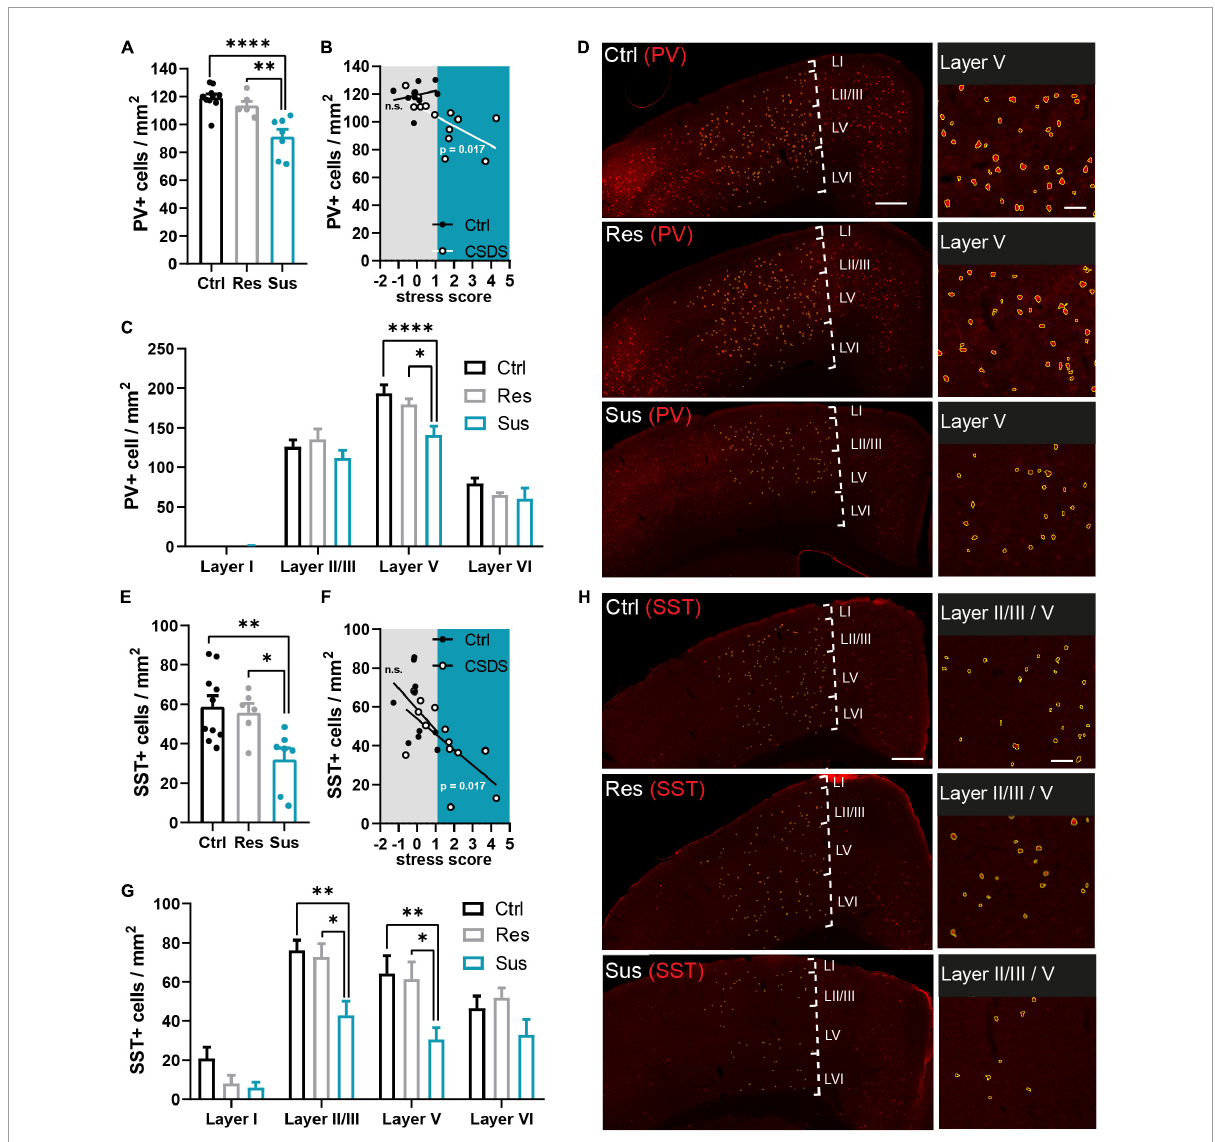
FIGURE2 Interneuron populations are reduced in the primary motor cortex long-term after CSDS depending on stress vulnerability. (A) Parvalbumin (PV+) cell density in the analyzed M1 area compared between the behavioral groups. (B) Predictive relationship of the stress score and PV+ cell density in M1 analyzed for the stressed and unstressed group (gray area: stress score spectrum of controls and resilient mice, blue area: stress score spectrum of susceptible mice). (C) Layer-wise assessment of the stress effect on PV+ cell density in M1. (D) Examples of the PV+ cells (red = PV+ immunostaining, yellow = outlines of PV+ cells identified via semi-automated image analysis) in M1 and affected layers. (E) Somatostatin (SST+) cell density in the analyzed M1 area compared between the behavioral groups. (F) Predictive relationship of the stress score and SST+ cell density in M1 analyzed for the stressed and unstressed group (gray area: stress score spectrum of controls and resilient mice, blue area: stress score spectrum of susceptible mice). (G) Layer-wise assessment of the stress effect on SST+ cell density in M1. (H) Examples of the SST+ cells (red = SST+ immunostaining, yellow = outlines of SST+ cells identified via semi-automated image analysis yellow outlines) in M1 and affected layers. ∗ P < 0.05, ∗∗ P < 0.01, ∗∗∗∗ P < 0.0001. Results are shown as mean ± SEM. Left: scale bar = 500 µ m, right: scale bar = 100 µ